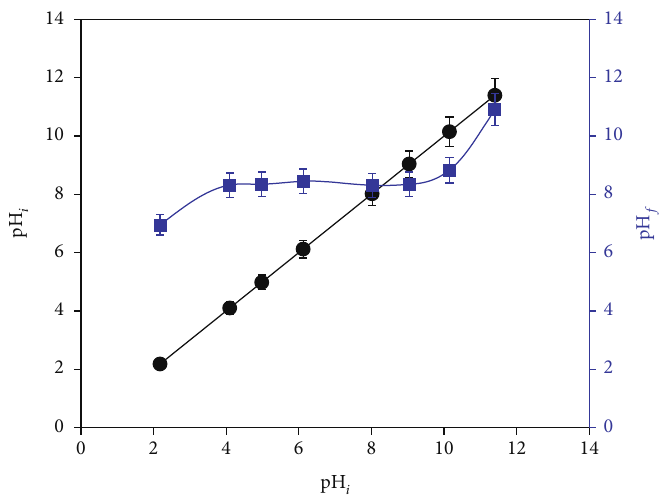
Figure 6: Determination of point of zero charges ( pH